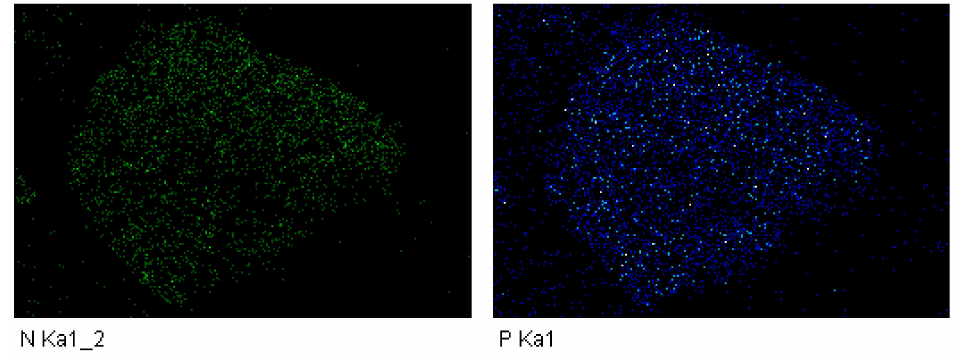
Figure 12. Mapping scan of adsorbed N and P elements of composite